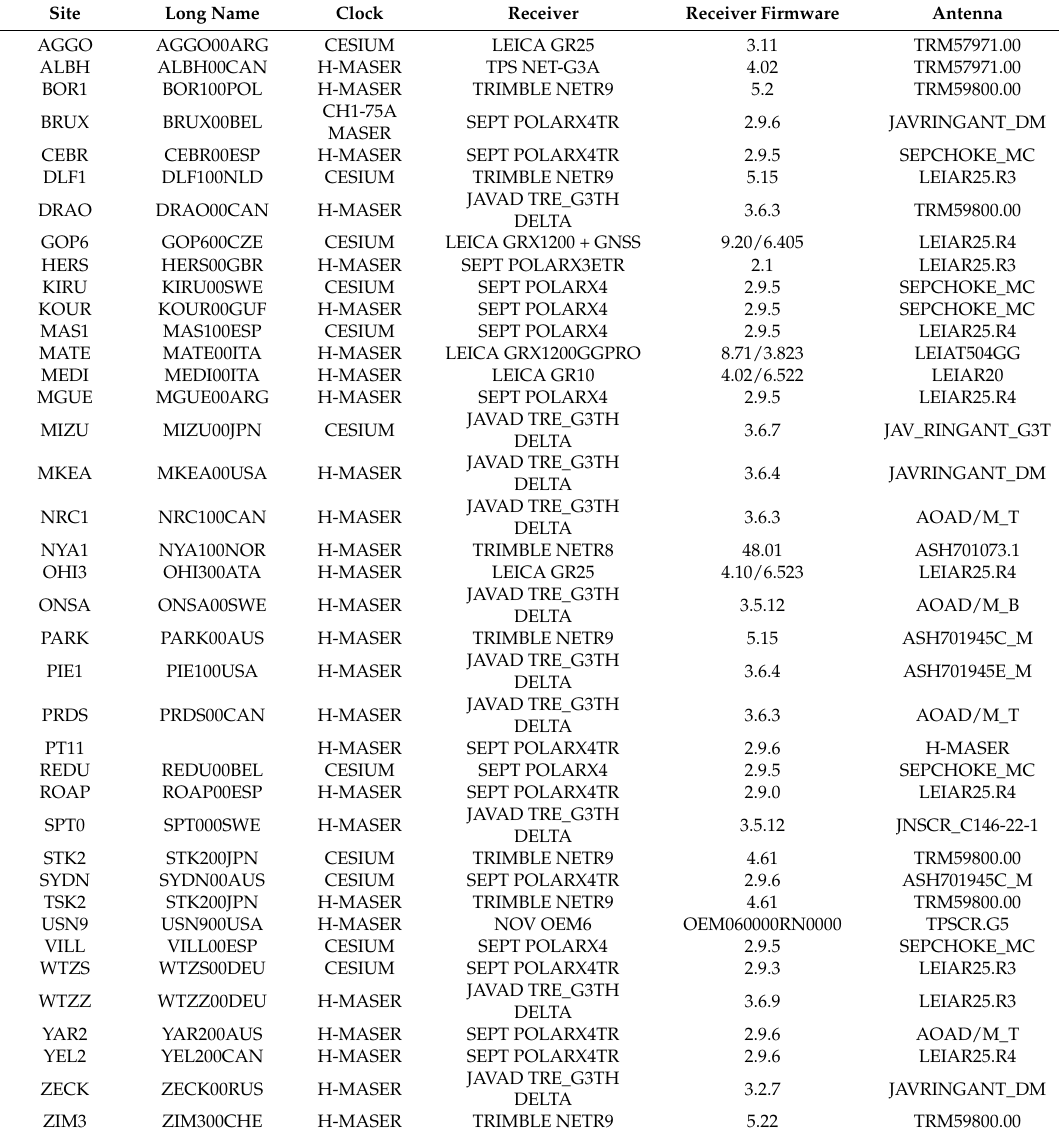
Figure 1. Geographical distribution of the selected 39 global tracking stations. Table 3. The detail information of selected IGS stations.